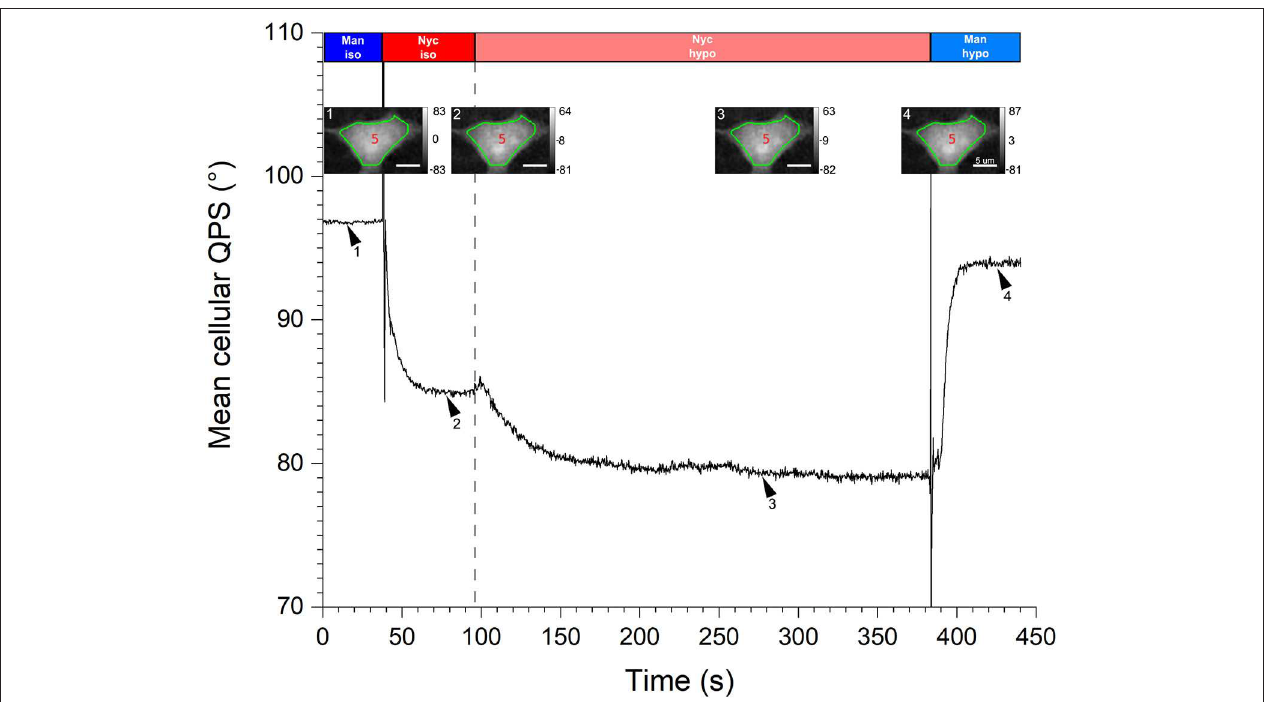
FIGURE 8 | Hypo-osmotic challenge. A graph of the mean cellular QPS of one HEK293T cell during a hypo-osmotic challenge is shown. The QPS is averaged over the cell body delineated by the green contour line, shown in the insets. The quantitative-phase images correspond to the time-points defined by the respective arrowheads. Rectangles across the top illustrate the perfusion sequence of the various solutions, namely the iso-osmotic mannitol (blue), iso-osmotic Nycodenz (red), hypo-osmotic Nycodenz (light red), and hypo-osmotic mannitol (light blue). The vertical gray dashed line indicates the onset of the hypo-osmotic challenge. The mean cellular QPS as well as the color bars of the insets are expressed in degrees and the scale bars are 5 µ m.